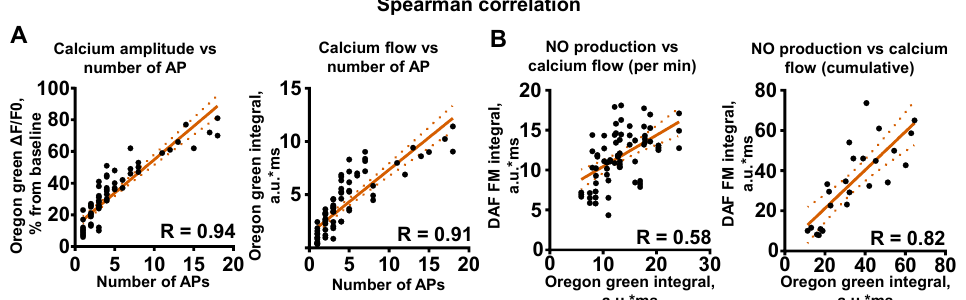
Figure 2. Spearman correlation analysis of action potentials, calcium events and nitric oxide pro- duction. ( A ) Left: correlation of SCE amplitude and number of action potentials in bursts. Right— correlation of SCE integral (arbitrary units * milliseconds) and number of action potentials in bursts. ( B ) Left: correlation of sum of integrals calculated for DAF-FM and Oregon Green for 1 min. Right: correlation of cumulative sum for integrals for 1–5 min of recording.